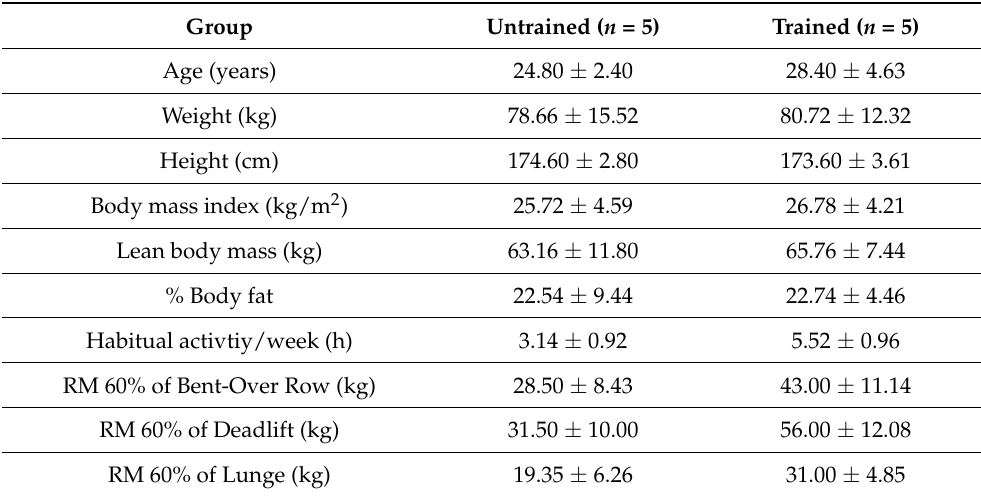
Table 1. Baseline Characteristics of Study Participants ( n =